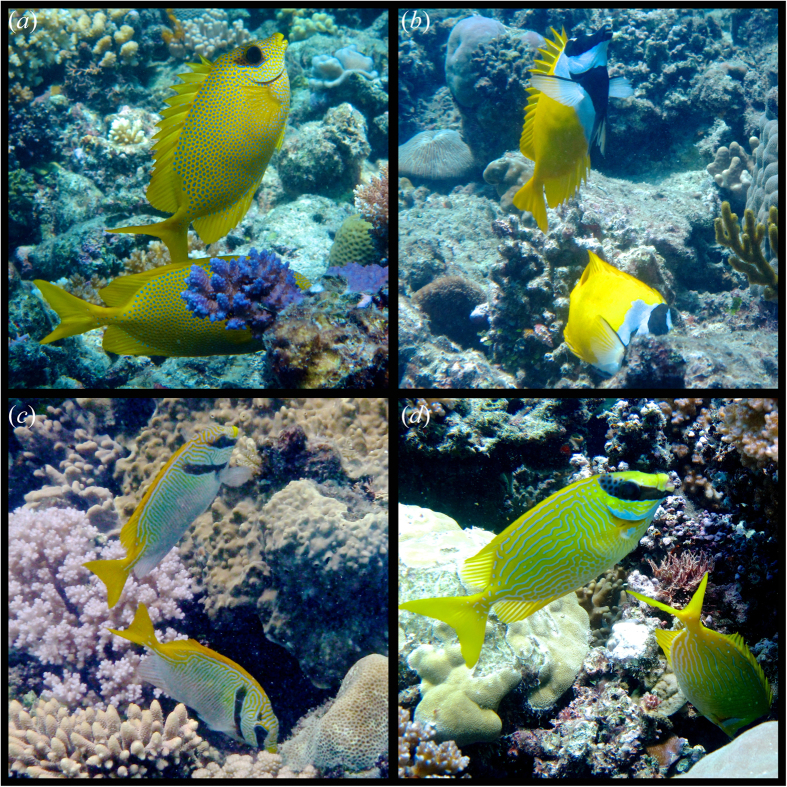
Foraging and vigilance postures in four species of pairing rabbitfishes.The foraging individual (in the head-down position) feeds in cracks and crevices in the substratum, while the vigilant individual is positioned in the water column with its head up. Note the obstructions to the visual field of the forager, suggesting high vulnerability to predation and the unobstructed field of perception of the vigilant fish. (a) Siganus corallinus, (b) S. vulpinus, (c) S. doliatus, (d) S. puellus. Photographs taken and owned by Jordan M. Casey, who gives permission for their publication under an Open Access license.